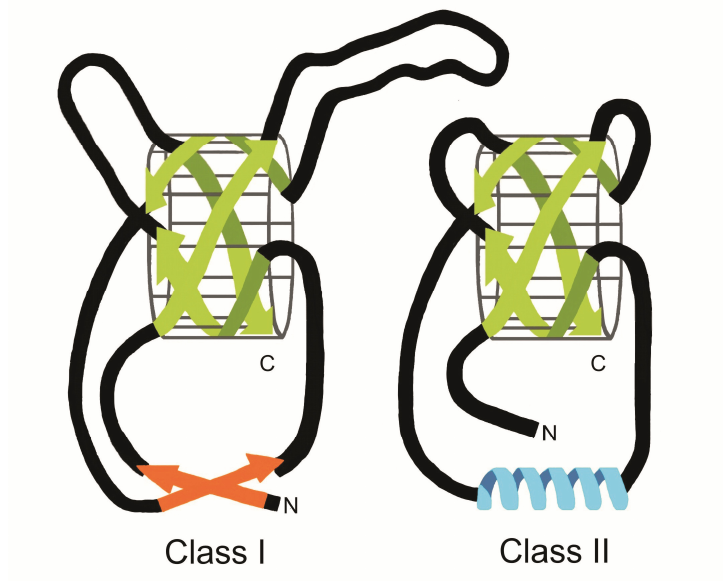
Figure 1. Schematic representation of the three-dimensional structure of class I and class II hydrophobins. Both types of hydrophobins contain a four-stranded β -barrel core. In class I hydrophobins two large disordered regions are present which are absent in class II hydrophobins. Finally, class I hydrophobins contain an additional two-stranded β -sheet structure, in class II hydrophobins this position is occupied by an α